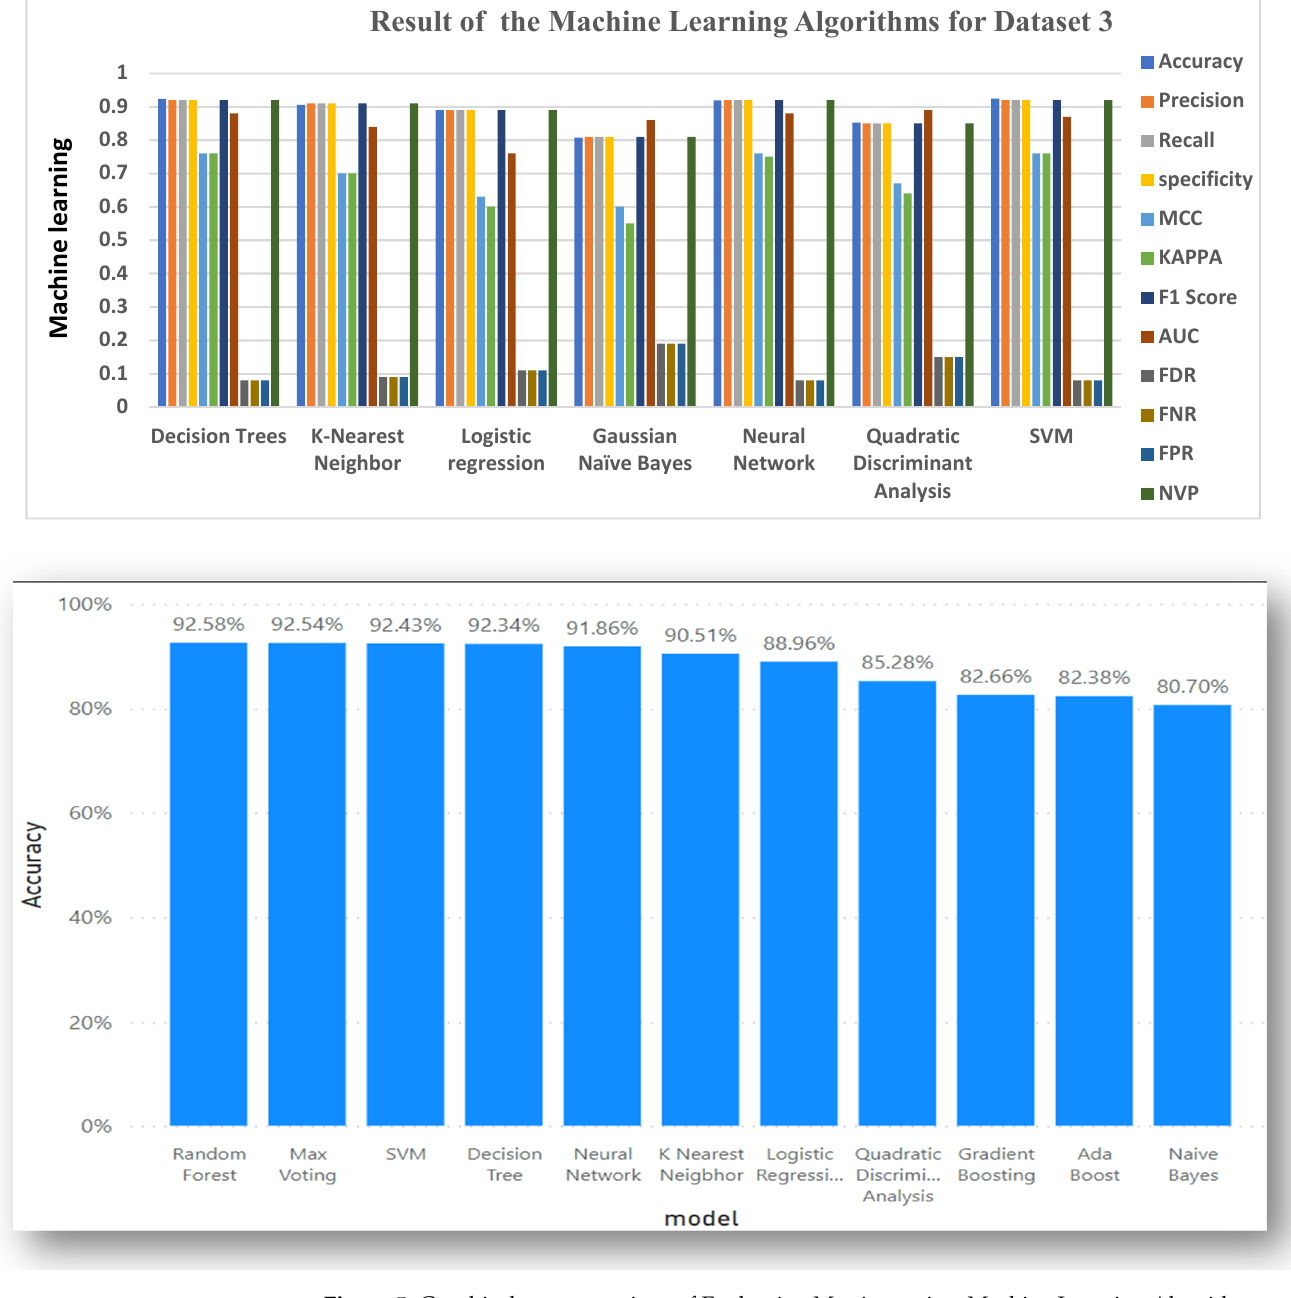
Figure 5. Graphical representations of Evaluation Metrics against Machine Learning Algorithms and ensemble learning for Dataset 3.